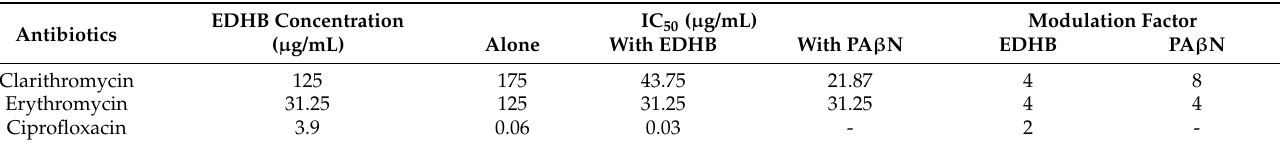
Table 1. Modulation assay of EDHB and the antibiotics on E. coli Kam3-AcrB.